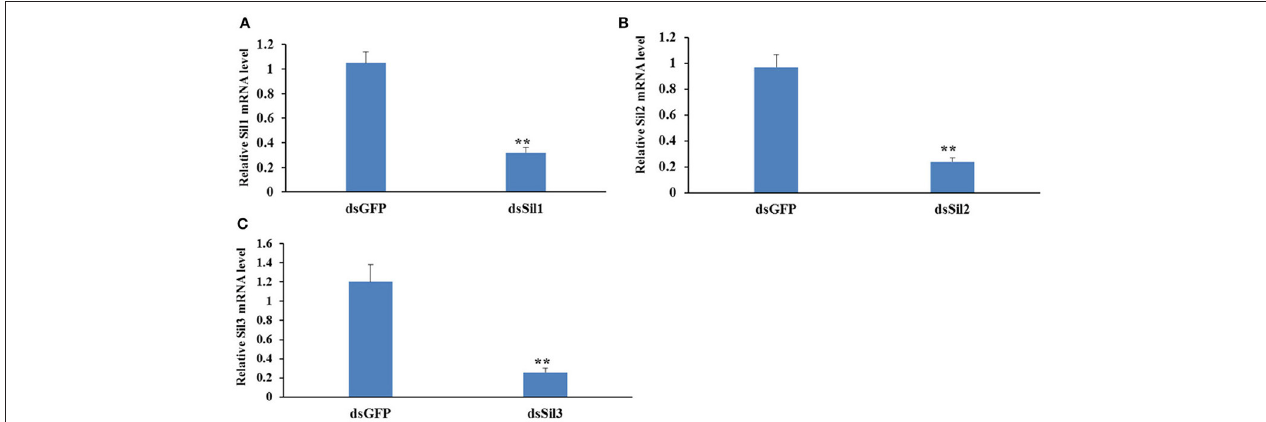
FIGURE 12 | Relative expression level of Sil genes analyzed by qPCR, the first larvae were fed 5 ug/ml dsRNA of Sil genes separately. (A) Relative expression level of Sil1 gene, fed on dsSil1 resulted in a silencing 73% for Sil1. (B) Relative expression level of Sil2 gene, fed on dsSil2 resulted in a silencing 69% for Sil2 . (C) Relative expression level of Sil3 gene, fed on dsSil3 resulted in a silencing 78% for Sil3 (** p < 0.01).